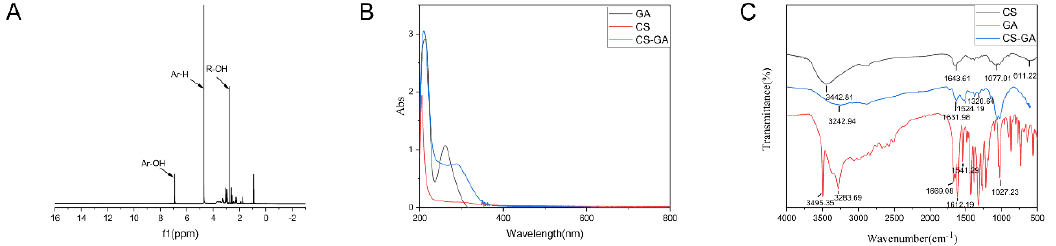
Figure 2. Characterization of CS-GA. ( A ) 1 H-NMR spectrum of CS-GA; ( B ) UV − vis spectra of CS-GA, GA, and CS; ( C ) FT - IR spectrum of CS, GA, and CS - GA.